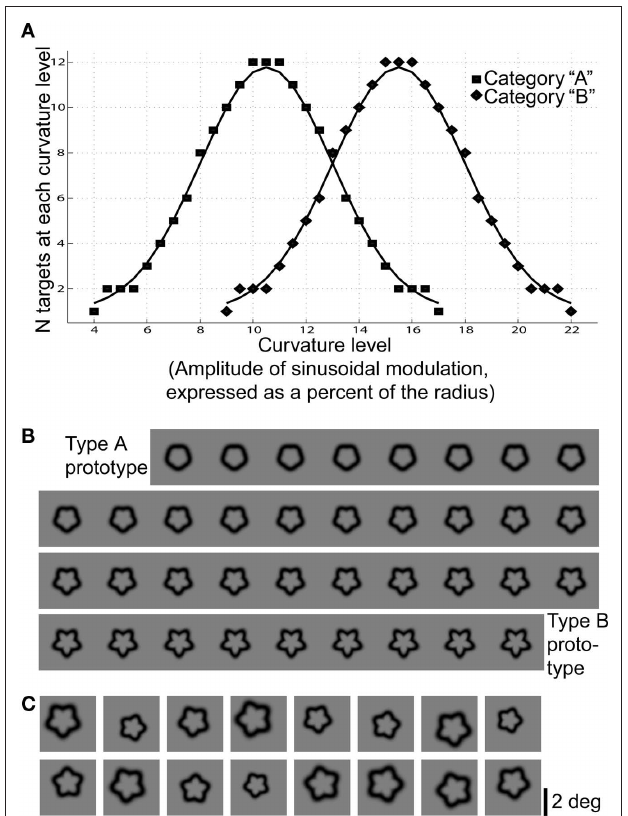
Figure 1 | Target distributions and visual appearance. (A) The distributions of Category A and B shapes shown during all fMRI runs were Gaussian and overlapping. Curvature levels between 9 and 17% of the radius were ambiguous, i.e., shapes of these curvature levels could be of either category. (B) The visual appearance of all curvature levels used. Neighboring shapes were difficult or impossible to discriminate from one another, preventing subjects from using a visual memorization strategy to perform the task. (C) In the experiment, the shapes were jittered in size, position, and orientation, as in the examples shown